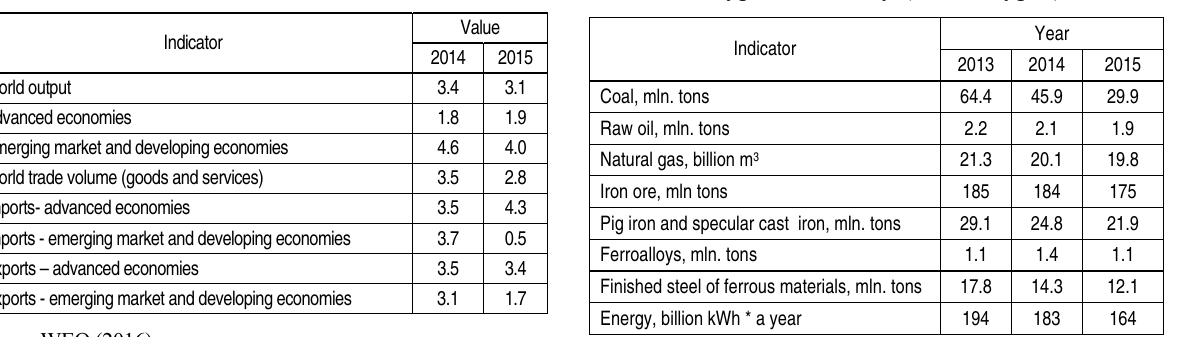
Table 1. Some indicators of development of the world economy, percent change to the previous year